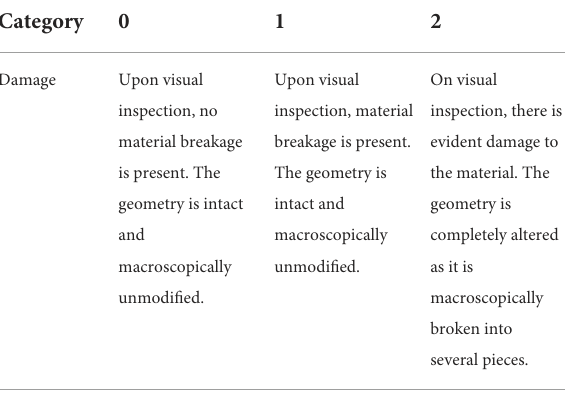
TABLE 1 Categories of damage to the 3D surgical model during sterilization.